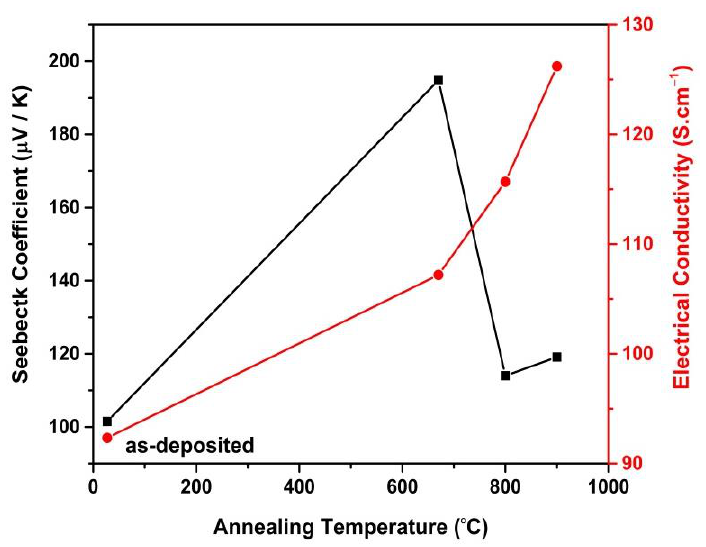
Figure 8. Effect of annealing temperature on Seebeck coefficient (left) and electrical conductivity (right) of SiGe thin films.